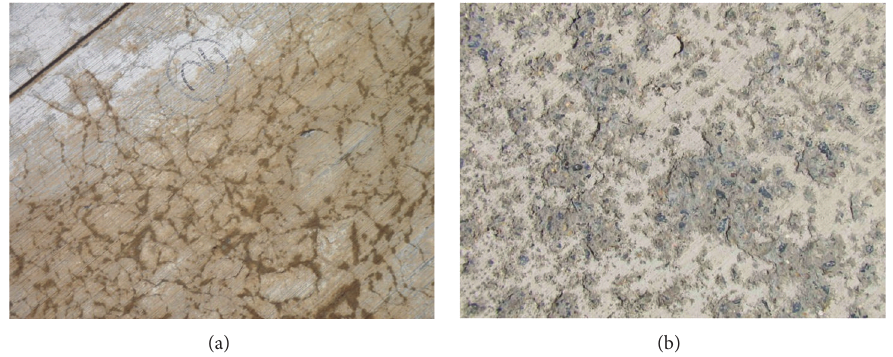
Figure 1: Deterioration characteristic of concrete in situ (a) cracking and (b) spalling.